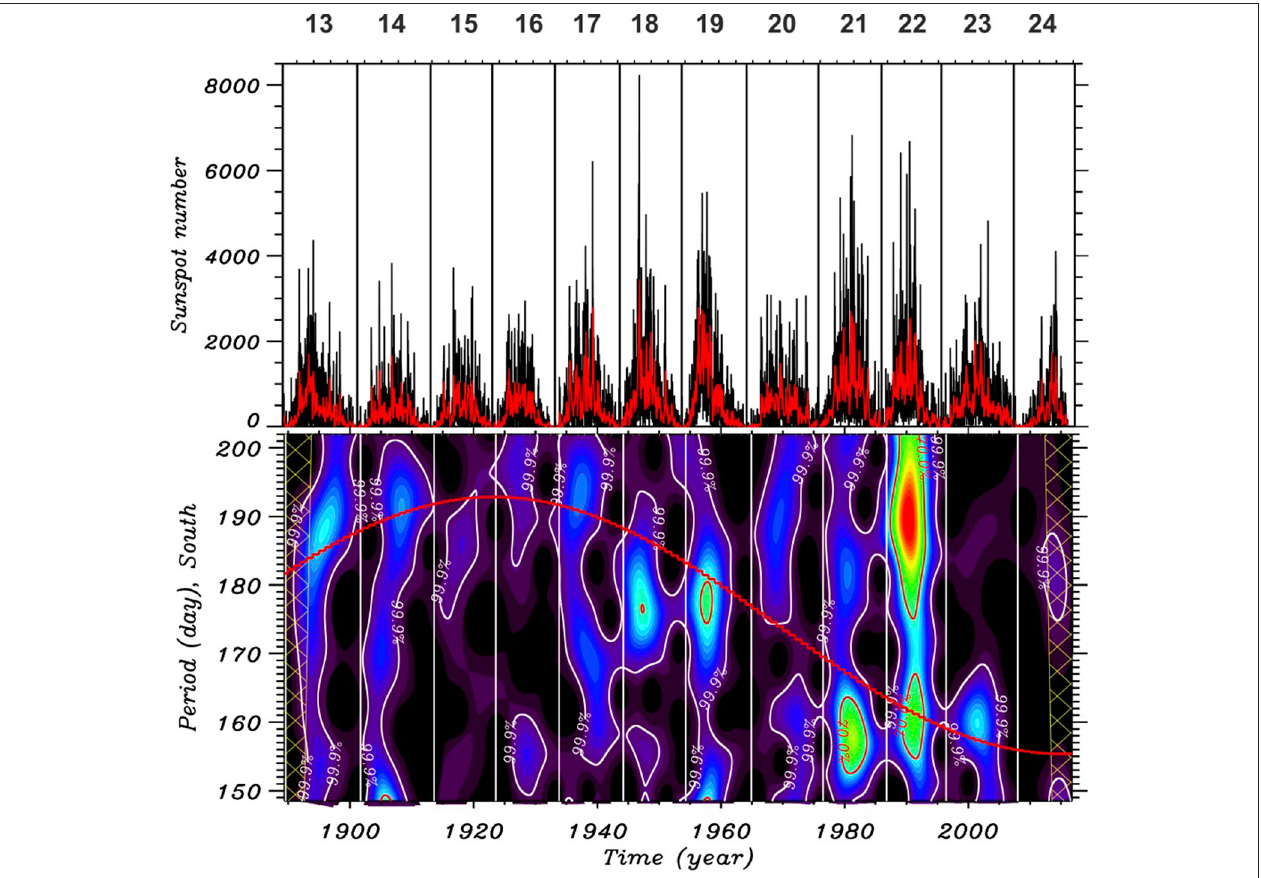
FIGURE 2 | The upper panel represents GRO daily (black) and monthly averaged (red) hemispheric sunspot area data for cycles 13–24 for the southern hemisphere. The lower panel shows the corresponding wavelet analysis.